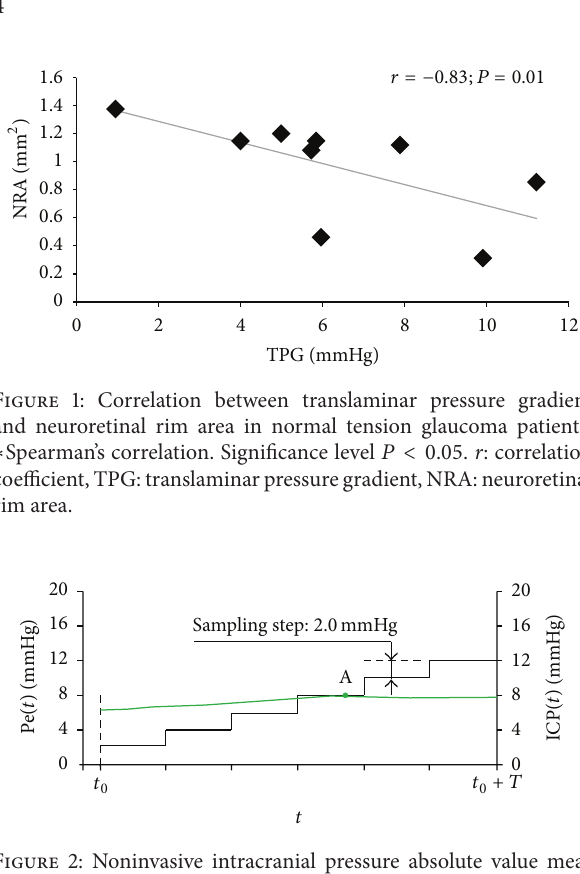
Figure 2: Noninvasive intracranial pressure absolute value mea- surement procedure. Time diagram of the externally applied pres- sure Pe( 𝑡 ) when pressure step is equal to 2 mmHg (solid black step function) and intracranial pressure ICP( 𝑡 ) (thin green line). Point (A) is pressure balance Pe = aICP point when pressure step is equal to 2 mmHg,